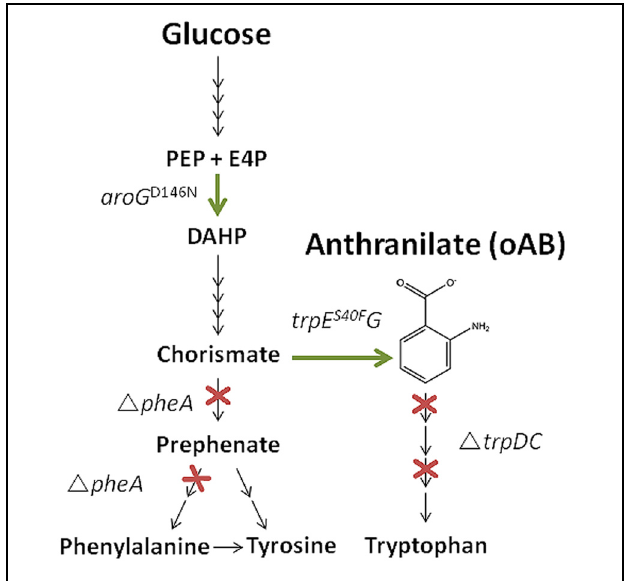
FIGURE 1 | Schematic oAB production pathway including the metabolic engineering targets investigated in this study (overexpression of aroG D146N trpE S40F G and deletion of trpDC and pheA) . PEP, phosphoenolpyruvate; E4P, erythrose-4-phosphate; DAHP, 3-Deoxy- D -arabinoheptulosonate-7-phosphate.